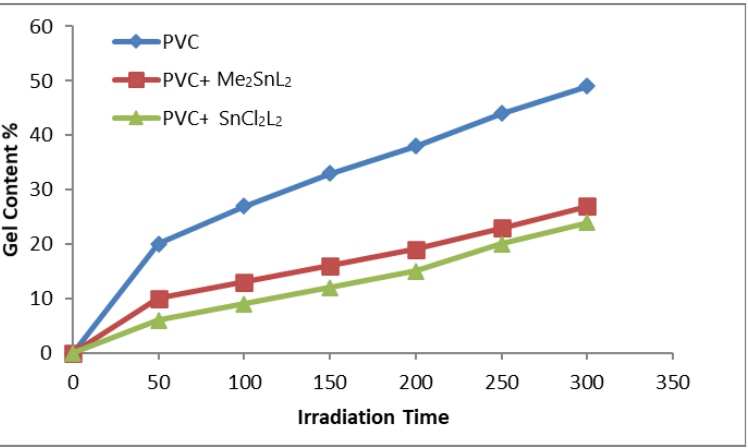
Figure 6. Gel content ratio relation with the irradiation time for the plain and modified PVC films.